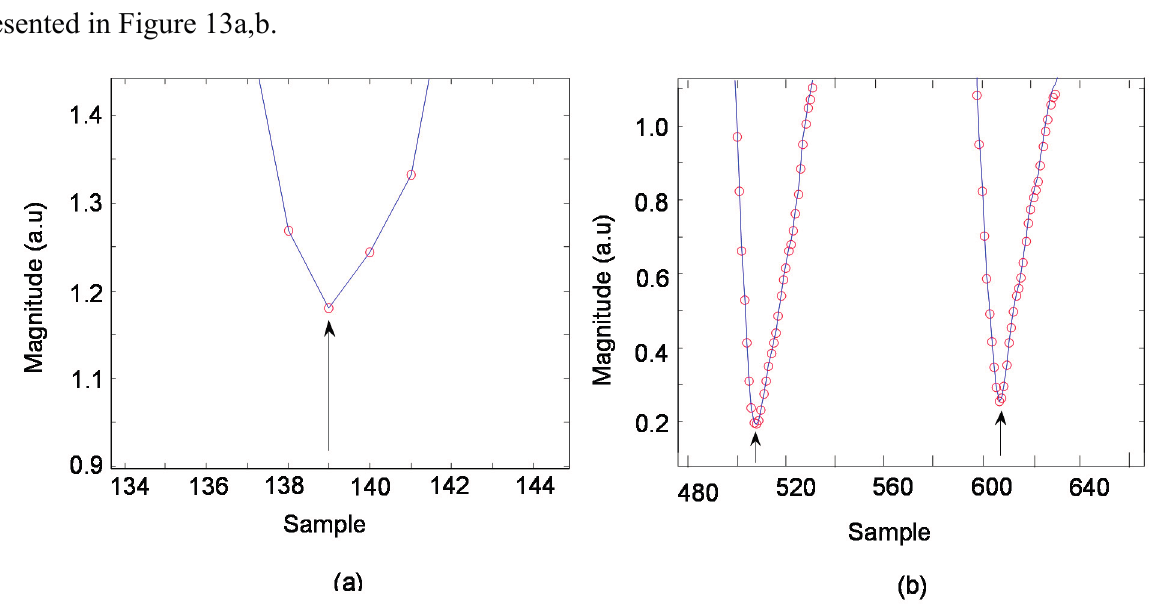
Figure 13. APTRD developed to detect a minimum valley of pulsatile features ( a ) at 139; ( b ) at 508 and at 607.